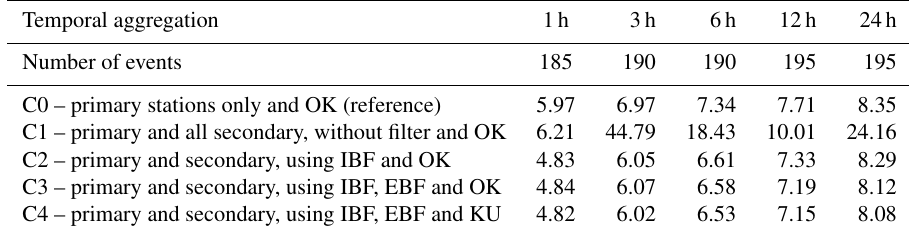
Table 5. RMSE (mm) for all stations and events.